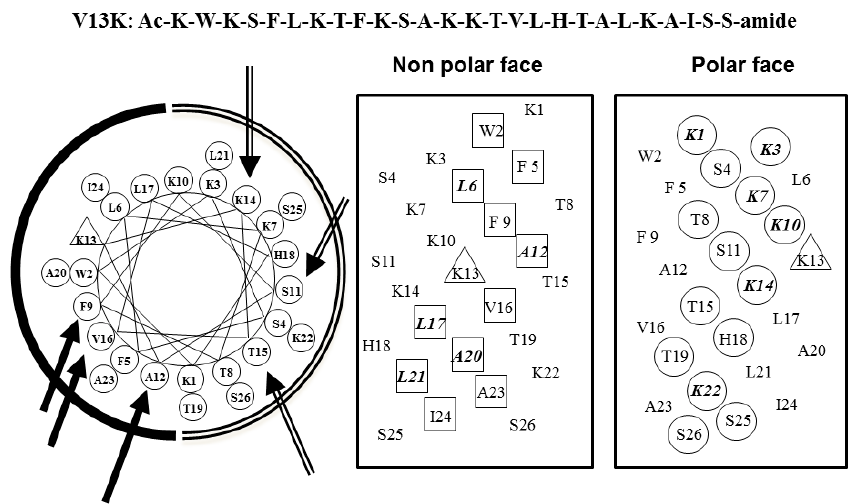
Figure 1. Representation of the parent peptide V13K as helical nets showing the polar/hydrophilic face (circled residues) and non-polar/hydrophobic face (boxed residues); and helical wheel, the lysine residue at position 13 of the sequence is denoted by a triangle. In the helical wheel, the three single substitution sites are shown with solid arrows on the non-polar face (solid arc), and hollow arrows on the polar face (open arc), respectively, One-letter codes are used for the amino acid residues.